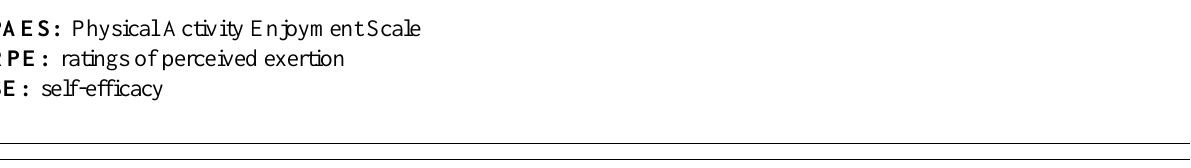
SE: self-efficacy